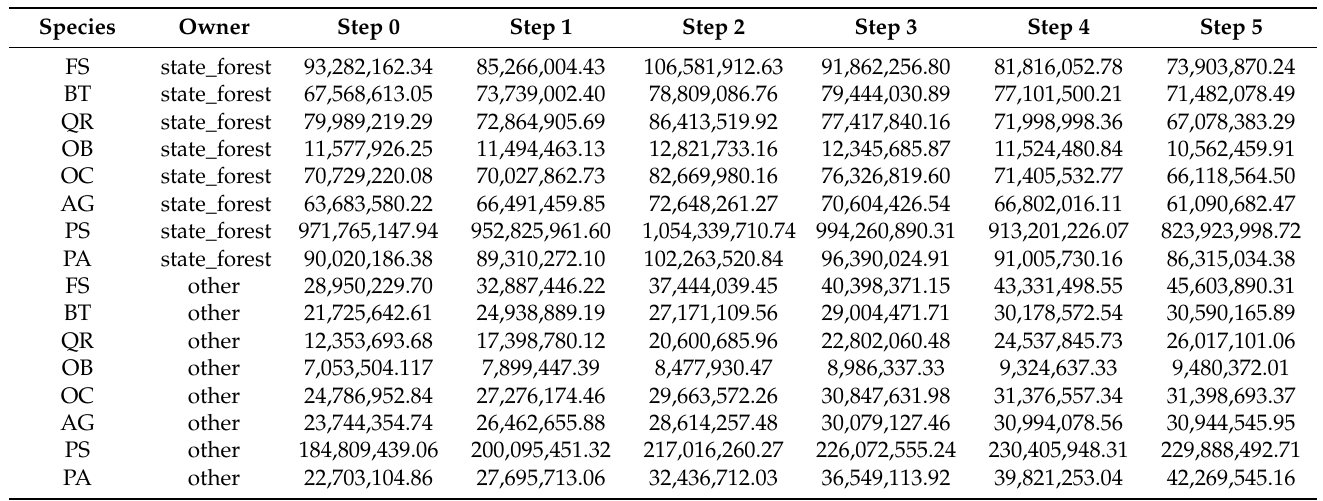
Table A1. Results from calculations conducted in EFDM software. Volume [m 3 ] by species and ownership type. Simulation in the time period (2010–2030), divided into 5-year simulation steps. Beech (FS), Birch (BT), Oak (QR), Other broadleaves (OB), Other coniferous (OC), Black alder (AG), Scots pine (PS), Norway spruce (PA).